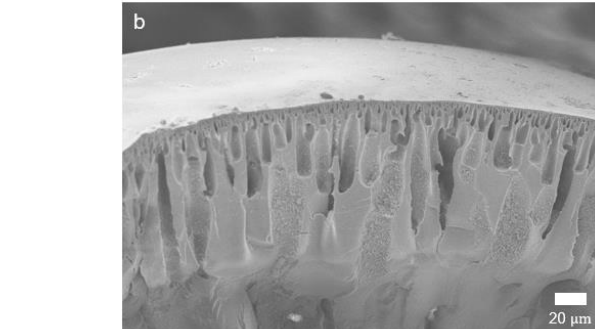
Figure 9. ( a ) Surface and ( b ) cross-sectional SEM images of the crosslinked PBI membrane after the filtration test at pH 13.